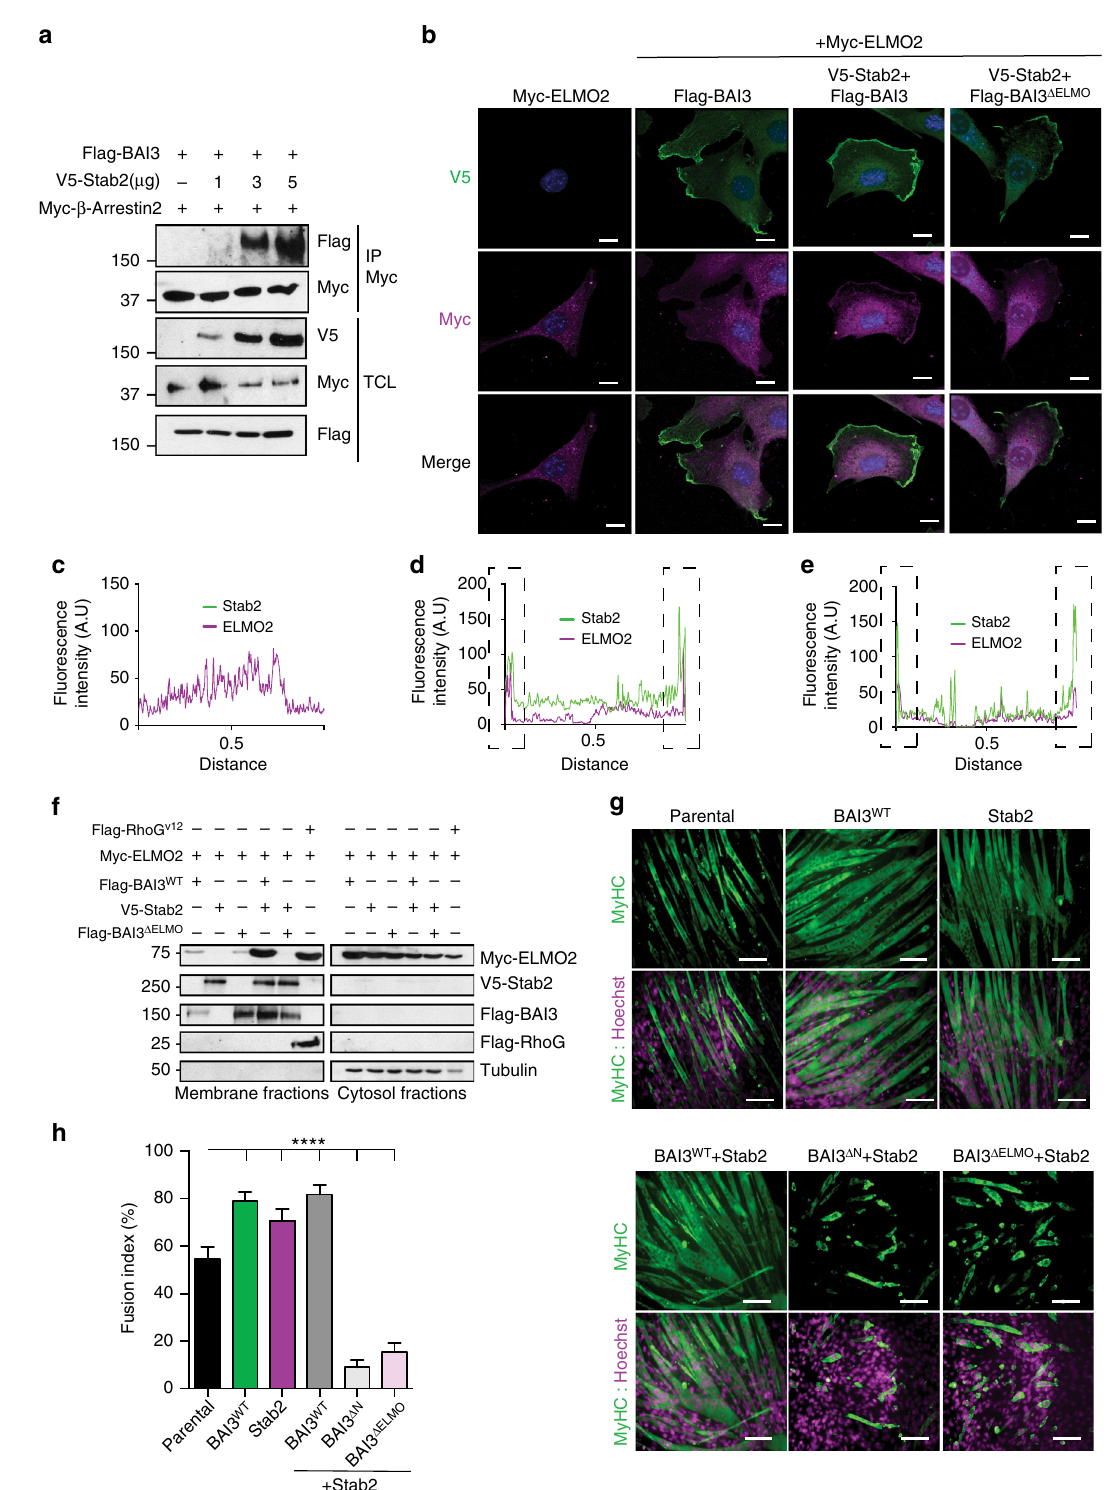
(Supplementary Fig. 9e, f) cells. However, BAI3 Δ N promoted the recruitment of Elmo2 at the membrane in C2C12 (Fig. 7e, g) and COS7 (Supplementary Fig. 9e, g) cells. To assess whether the recruitment of Elmo2 at the membrane was driven by the activation of G-proteins, or alternatively directly by the C- terminal Elmo-binding region of BAI3, we generated a BAI3 Δ N mutant lacking Elmo-binding activity (BAI3 Δ N/ Δ ELMO ). We